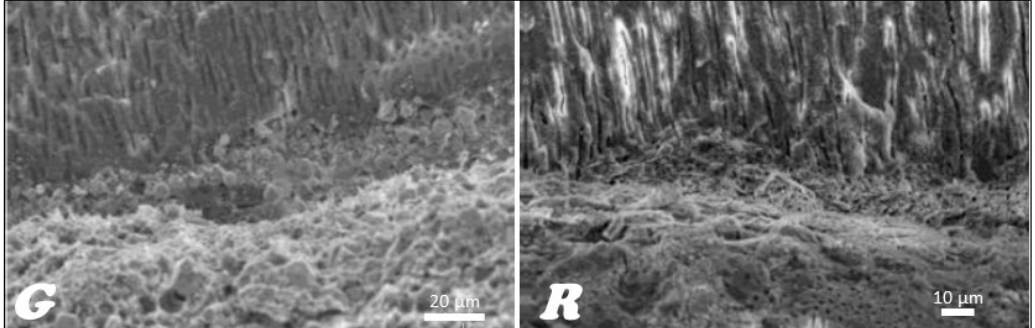
Figure 22. The borderline of the root canal wall, a thin intermediate layer of sealant and THC thermoplastically placed filling material: ( G ) gutta ‐ percha ‐ based filling material with a visible cross ‐ section of dentinal tubules along their trans ‐ verse to the axis of the root canal; ( R ) resilon with visible flake structure in the sealant interlayer; SEM.